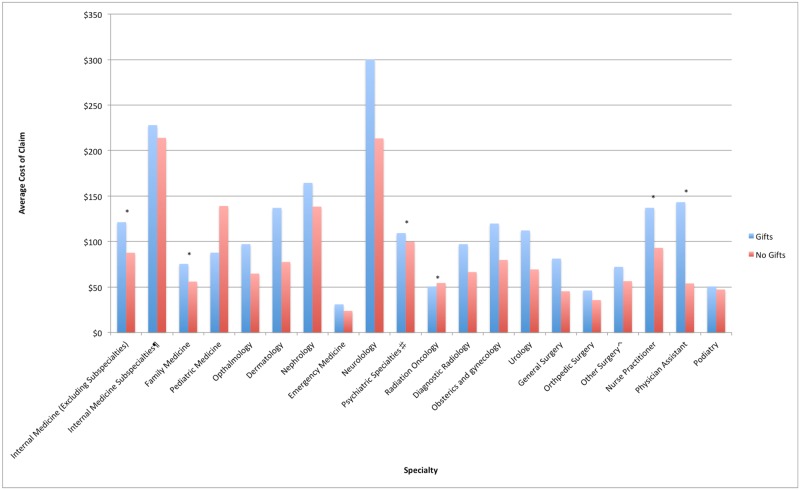
Average cost of claims by specialty for gift and non-gift recipients. ¶ Internal Medicine Specialties includes Cardiology, Endocrinology, Gastroenterology, Infectious Disease, Pulmonary Disease. ♯ Psychiatric Specialties includes Psychiatry, Psychiatry & Neurology, Neuropsychiatry, Geriatric Psychiatry. ⌃ Other Surgery includes Cardiac, Colorectal, Maxillofacial, Oral and Maxillofacial, Plastic and Reconstructive, Plastic, Neurological, Thoracic and Vascular Surgery. *Statistically Significant (p<0.05).